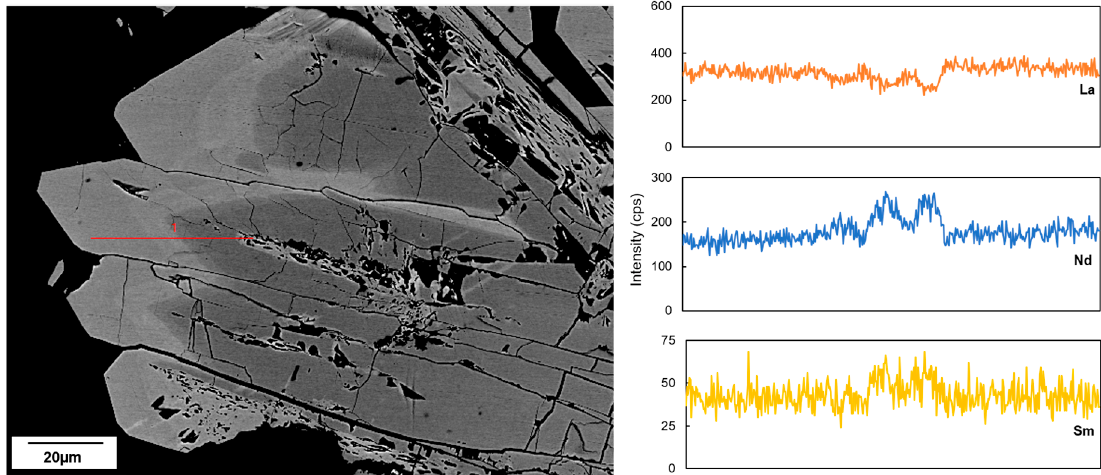
Figure 8. Backscatter electron image of texturally and compositionally zoned monazite ( left ) and compositional variation of REE (La, Nd, and Sm) along the red line on monazite crystal ( right ).